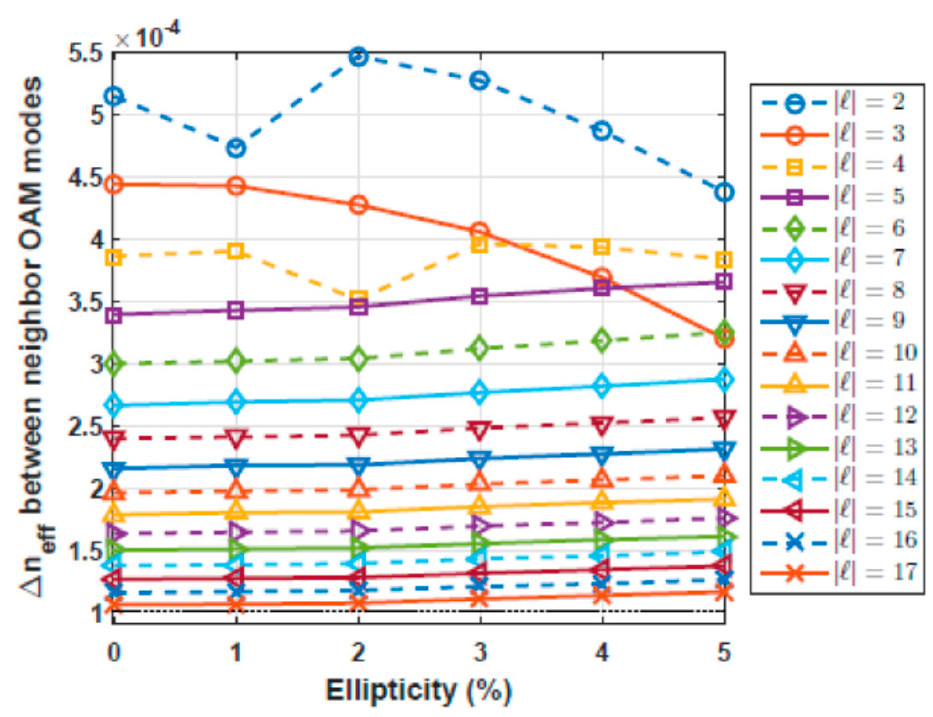
Figure 9. ∆ ne f f as a function of the variations in the circularity of the Figure 9. ∆ n e f f as a function of the variations in the circularity of the ring.